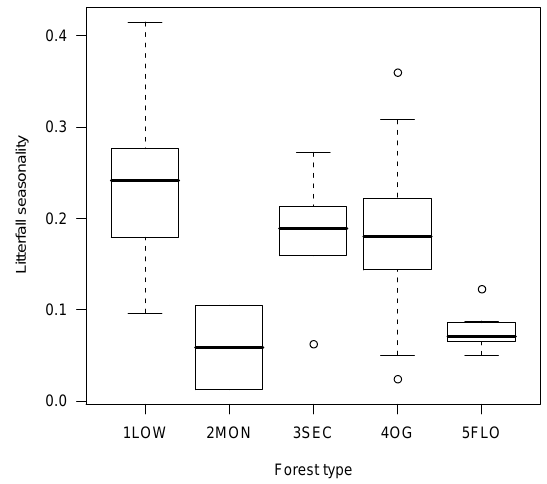
Fig. 6. Total annual litterfall versus C:N ratio. The correlation is not significant (Kendall rank test: p-value=0.16).